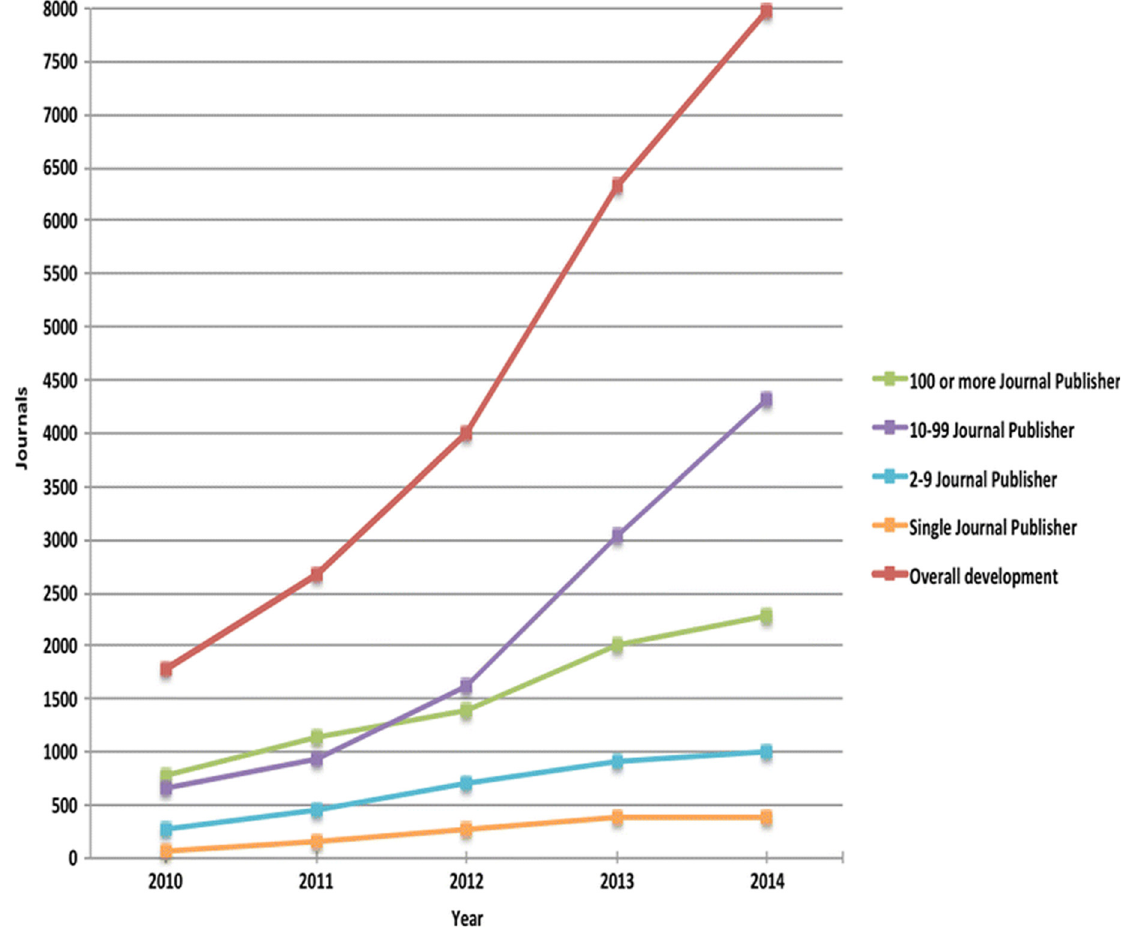
Figure 4. Active predator OA journals, 2010 – 2014